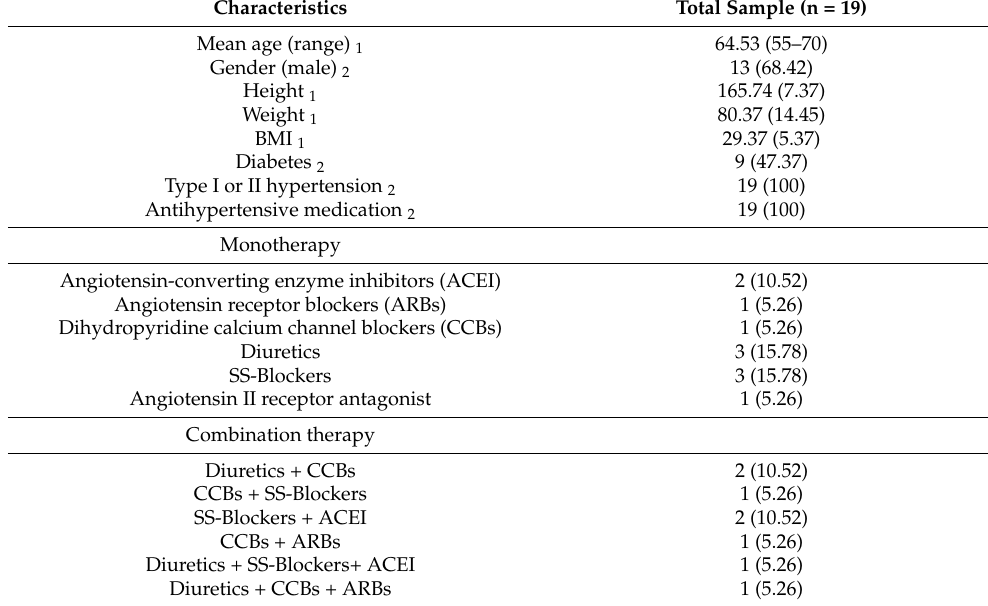
Table 1. Anthropometric and metabolic characteristics of the